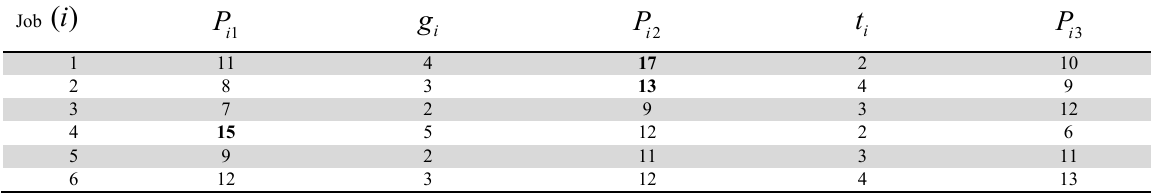
Effect of original processing times due to PM times